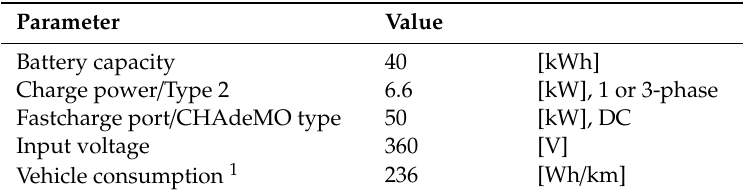
Table 1. Electrical specification data for Nissan Leaf 2018 electric vehicle (EV) [51].